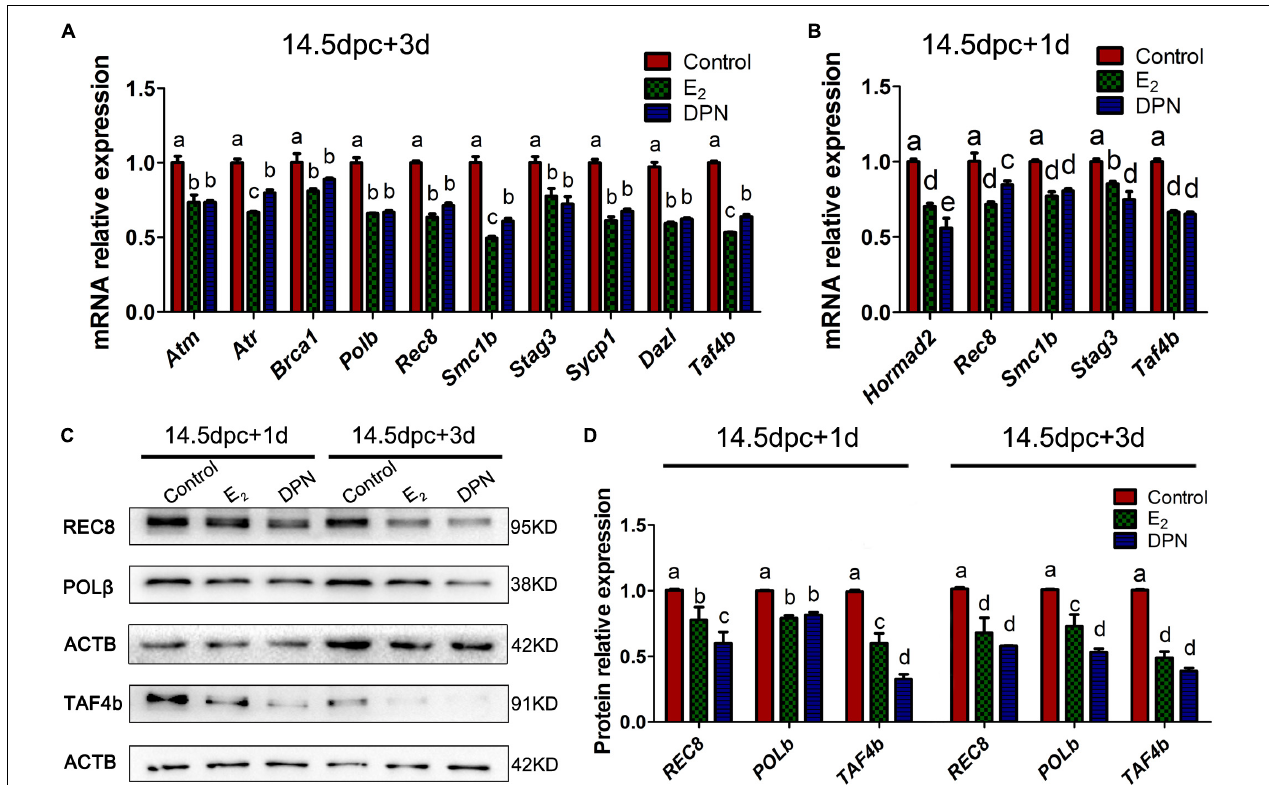
FIGURE 6 | Activation of ESR2 Disrupts expressions of key meiotic genes. Ovaries of 14.5 dpc were cultured. E2 and DPN decreased the mRNA expressions of key meiotic genes in cultures for 3 days (A) or 1 day (B) . E2 and DPN decreased the protein expressions of key meiotic genes in cultures for 1 day or 3 days (C,D) . Different letters: P <